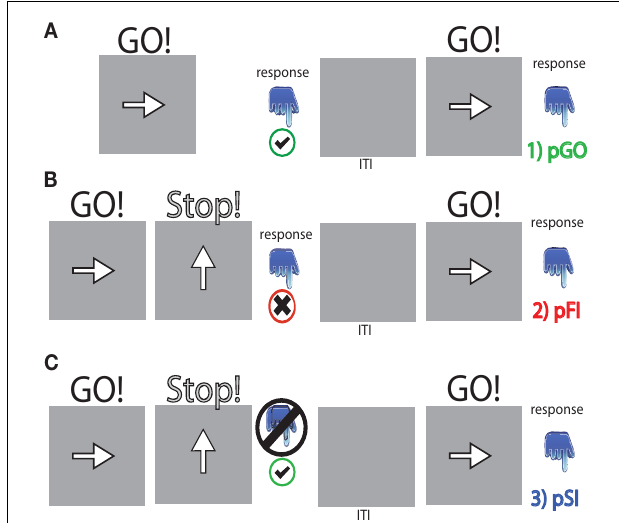
FIGURE 1 | Task schematic for each trial type. (A) pGO = a “GO” trial following a “GO” trial, (B) pFI = a “GO” trial following a failed inhibition (FI) trial, (C) pSI = a “GO” trial following a successful inhibition (SI) trial. “GO” stimuli were presented for [1000ms—the stop signal delay] calculated for each “STOP” signal event. The inter-trial interval (ITI) was between 1.6 and 1.9s in